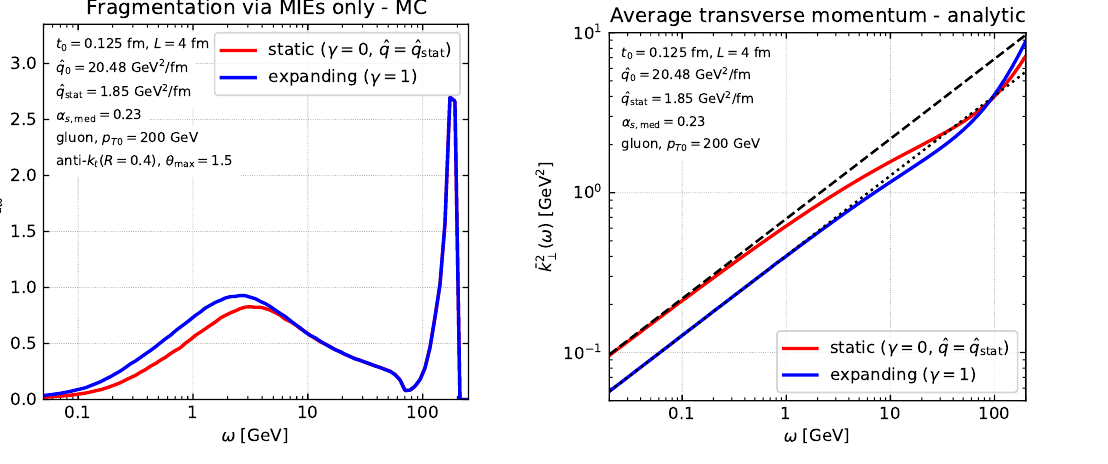
Figure 2. Scaling violations induced by transverse momentum broadening in medium-induced cascades. For all these results, the jet is triggered by a leading gluon with energy p T 0 = 200 GeV. rate (2.9), which scales like p ˆ q ( t ) . In principle, exact scaling can be recovered by